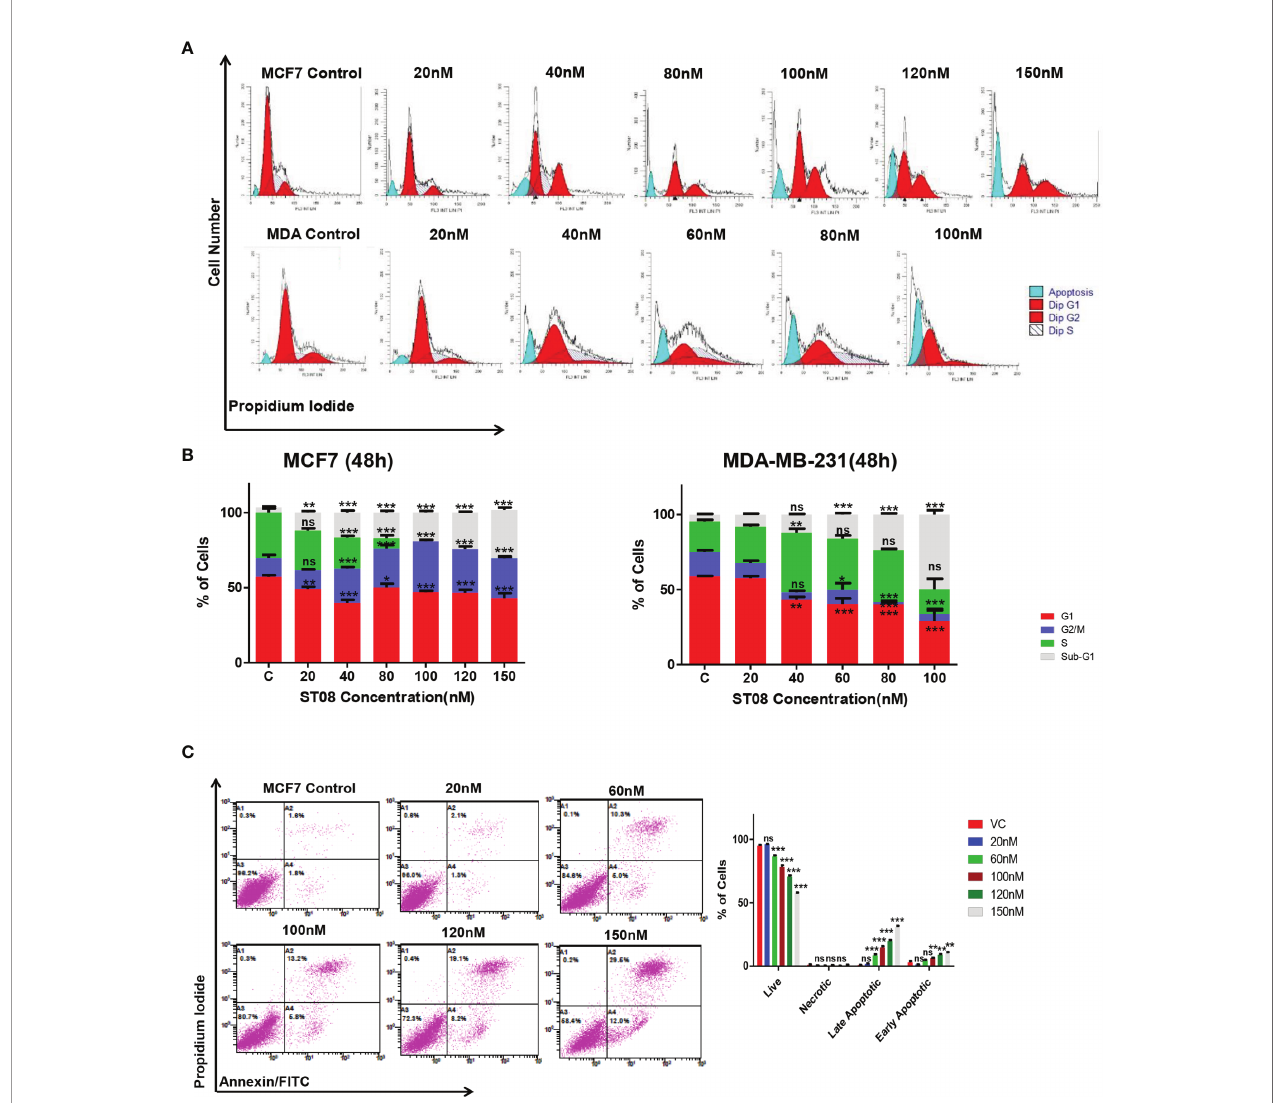
FIGURE 1 | Evaluation of cell cycle progression and cell death modality in breast cancer cells after ST08 treatment: Cell cycle pro fi le (A) of 48h ST08 treated MCF7, MDA- MB-231 cells and Quanti fi cation of percentage (B) of MCF7 and MDA-MB-231 cells in each phase of the cell cycle is depicted as a bar graph of mean ± SEM after 48h treatment of ST08. Each experiment was repeated three times and represented as histograms. Two-way ANOVA test was performed and p-value was calculated between control and ST08 treated groups (*p < 0.05, **p < 0.005, ***p < 0.0001. (C) Phosphatidylserine externalisation assay was performed on MCF7 cells after ST08 treatment. Dot plot depicting MCF7 cells treated with ST08 (20,60,100,120nM) for 48h followed by double staining with Annexin-FITC/PIand quanti fi cation of cells in different stages. Each experiment was repeated thrice. Two-way ANOVA test was performed and p value was calculated between control and ST08 treated groups (*p < 0.05, **p < 0.005, ***p < 0.0001, ns, not signi fi